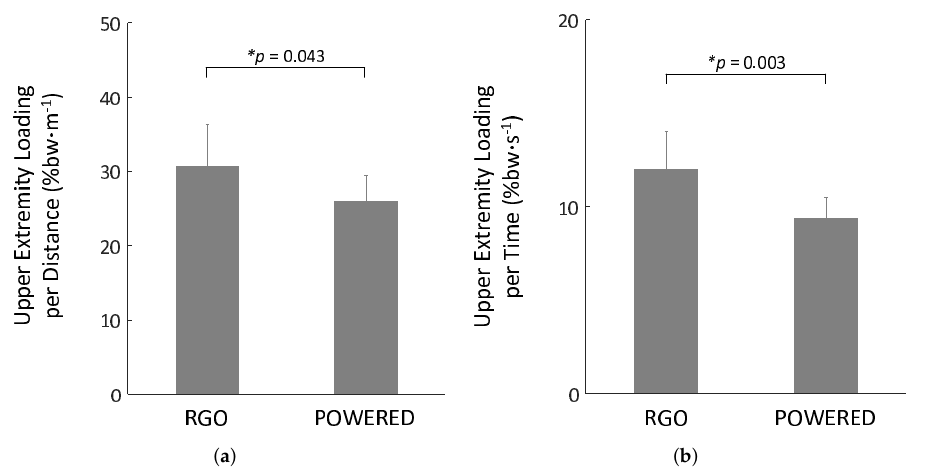
Figure 9. Average upper extremity loading per unit distance ( a ) and per unit time ( b ). Bars are means, error bars are standard deviations, and asterisks denote statistical significance.